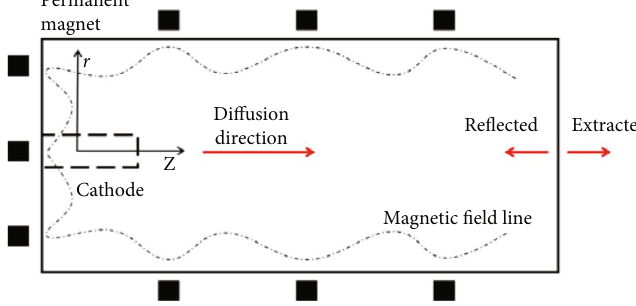
Figure 4: Structure diagram of radial di ff usion. Table 3: The case group setting for axis distribution of primary